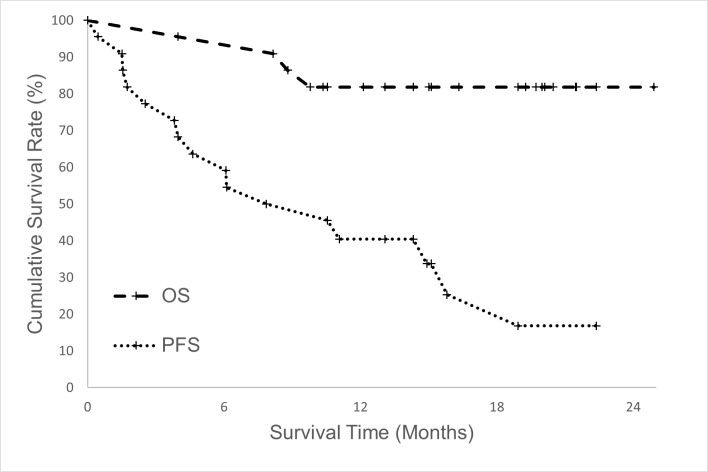
Overall survival and progression-free survival.The overall survival (OS) rate (dotted line) and progression-free survival (PFS) rate (dashed line) of HCC patients with normal liver volume < 800 cm3. The patient number was 22. The 1-year progression-free survival and overall survival rates were 40.4% and 81.1%, respectively.